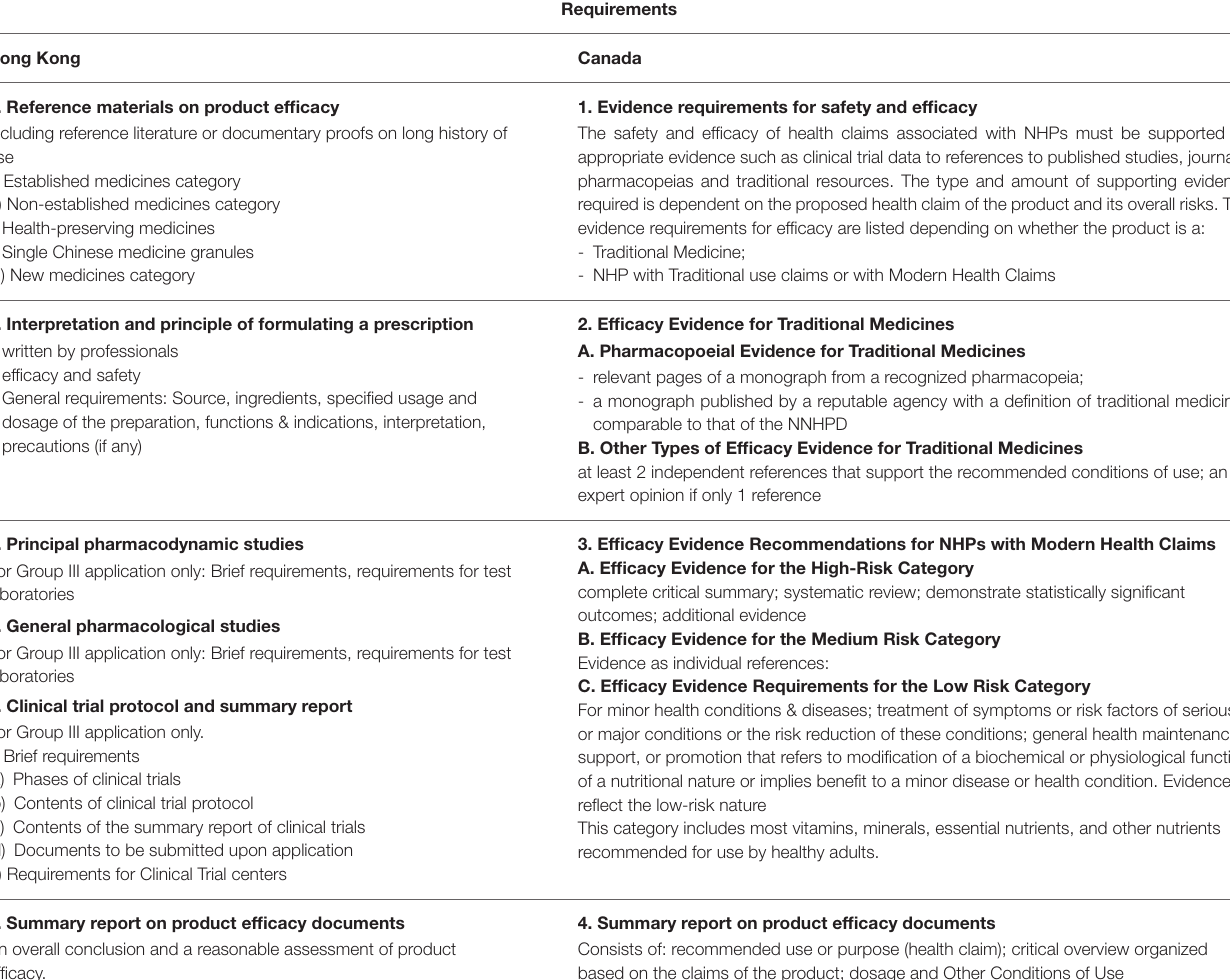
TABLE 4 | The efficacy requirements of proprietary Chinese medicines in Hong Kong and Canada (11,